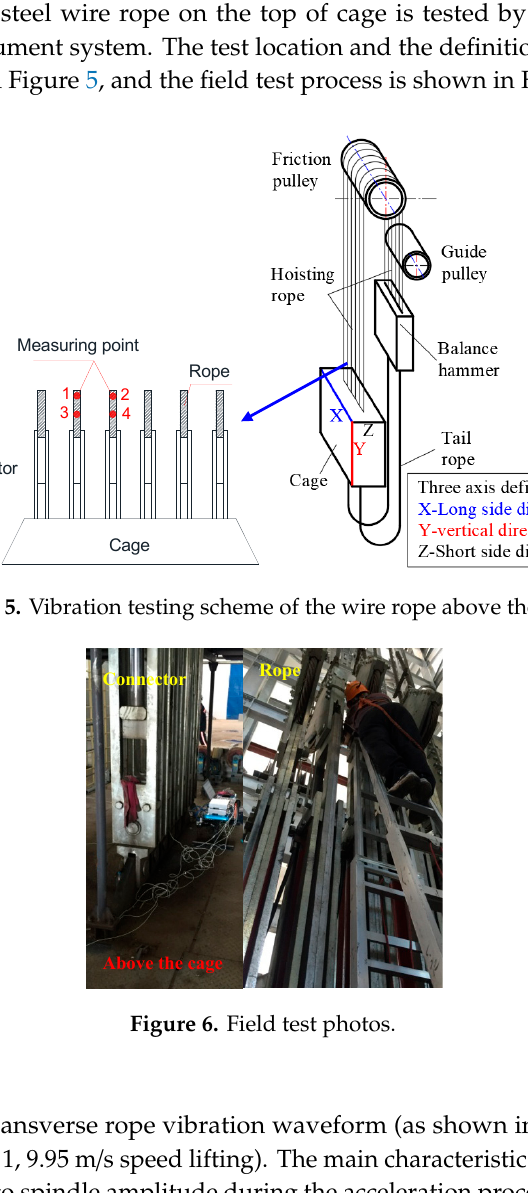
Table 3. Parameters of the global hoisting model. Item